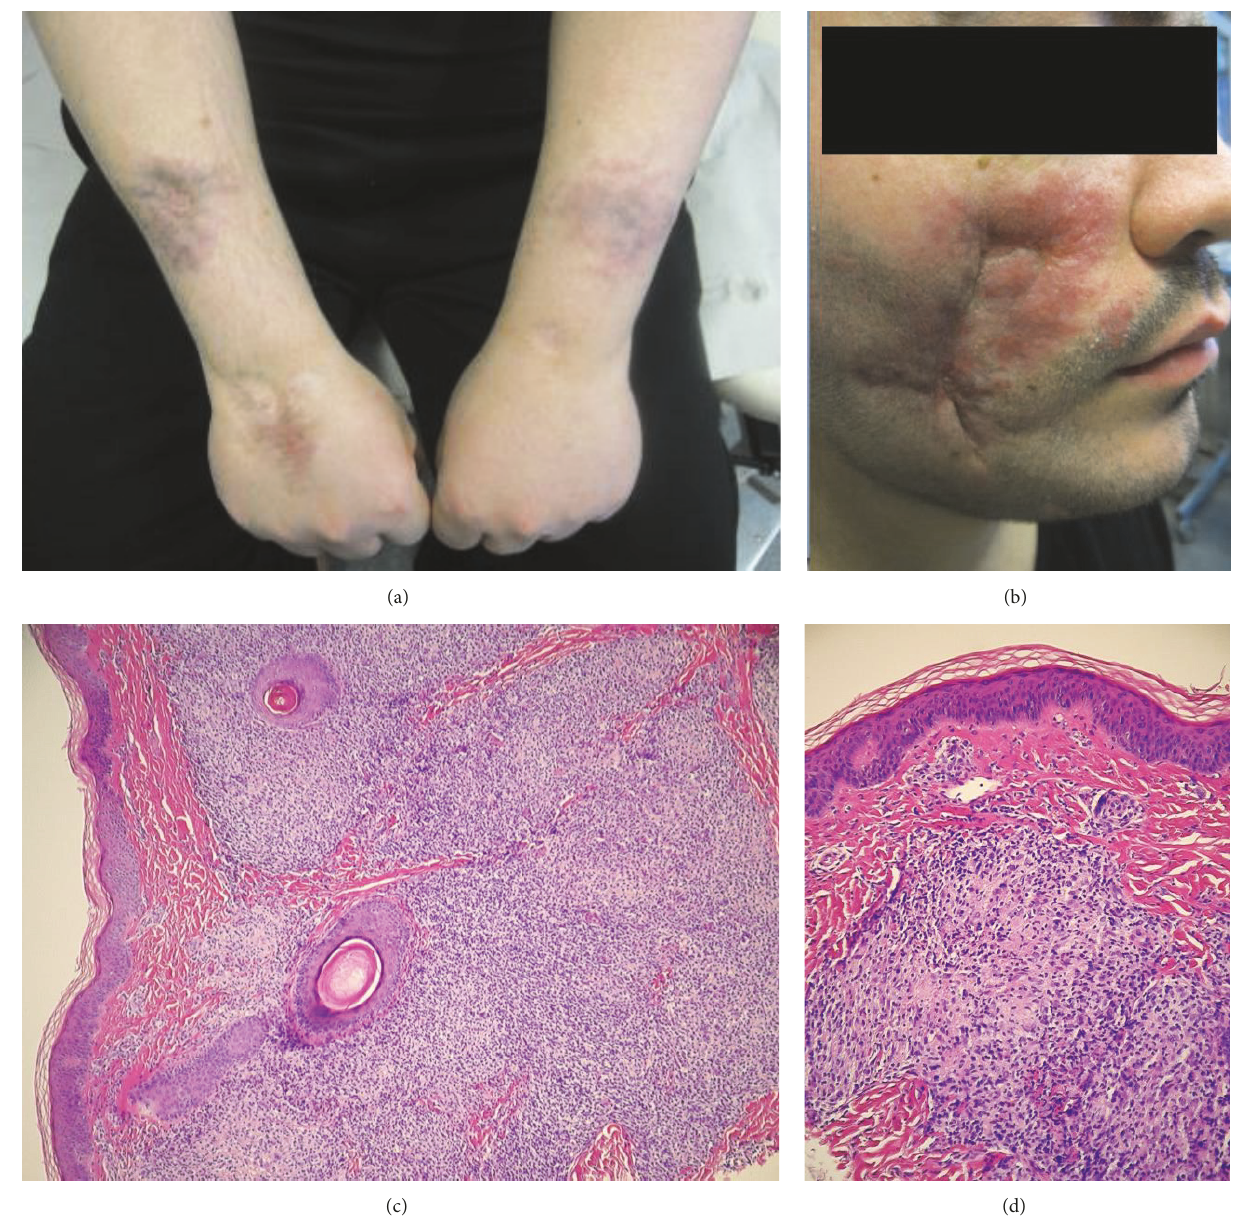
Figure 1: Skin lesions. (a) multiple scar-like bluish-red lesions on both arms. (b) indurated, erythematous scar-like lesion on the left cheek. (c, d) Skin biopsy showing massive lymphohistiocytic infiltration focally with formation of granulomas (H&E, 100x and 400x, resp.). There was a dominance of CD8+ T-cells and also an increased proportion of CD4/CD8 double-negative T-cells.